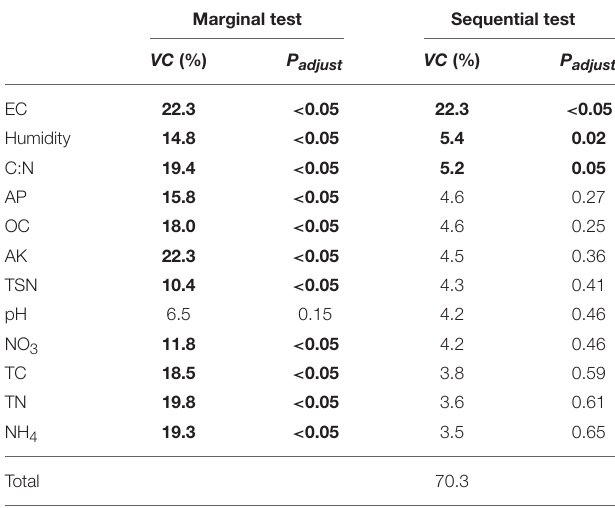
between edaphic variables and microbial communities. Marginal